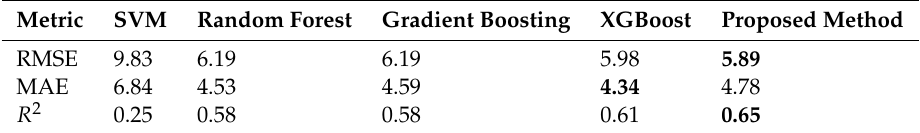
Table 5. Regression results comparing with the proposed method. Better results are highlighted in bold. Metric SVM Random Forest Gradient Boosting XGBoost Proposed